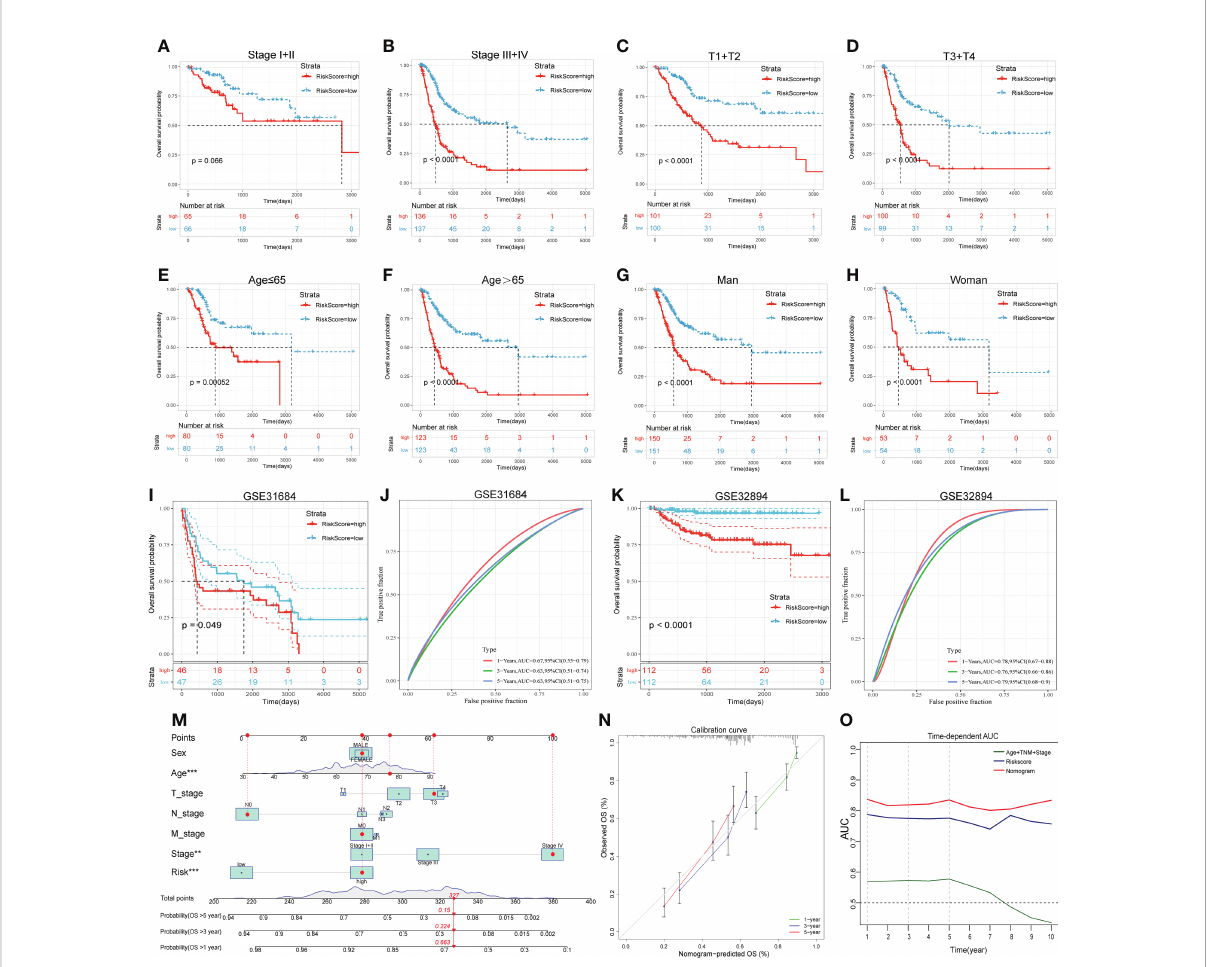
FIGURE 5 Subgroup analysis, external validation and nomogram proved the predictive value of the 14-gene signature. (A-H) The KM survival curves of OS between high and low RS groups in different subgroups. (I-L) The KM survival curves of OS between high and low RS groups and the time- dependent ROC curves of validation cohorts. I and J, GSE31684. K and L, GSE32894. (M) The nomogram created by integrating clinical information and Riskscore. (N) Calibration curve of the nomogram. (O) Time-dependent AUC curves of different prognostic